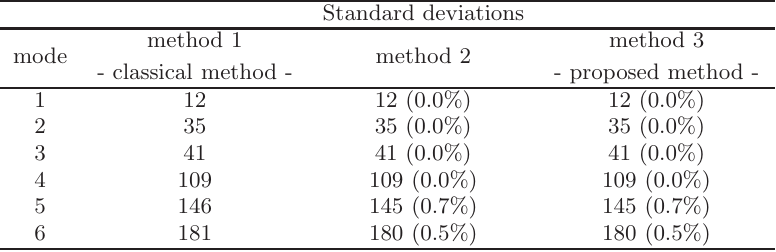
Table 4. The Standard Deviations of the six first natural frequencies of the propeller ( and the relative errors )